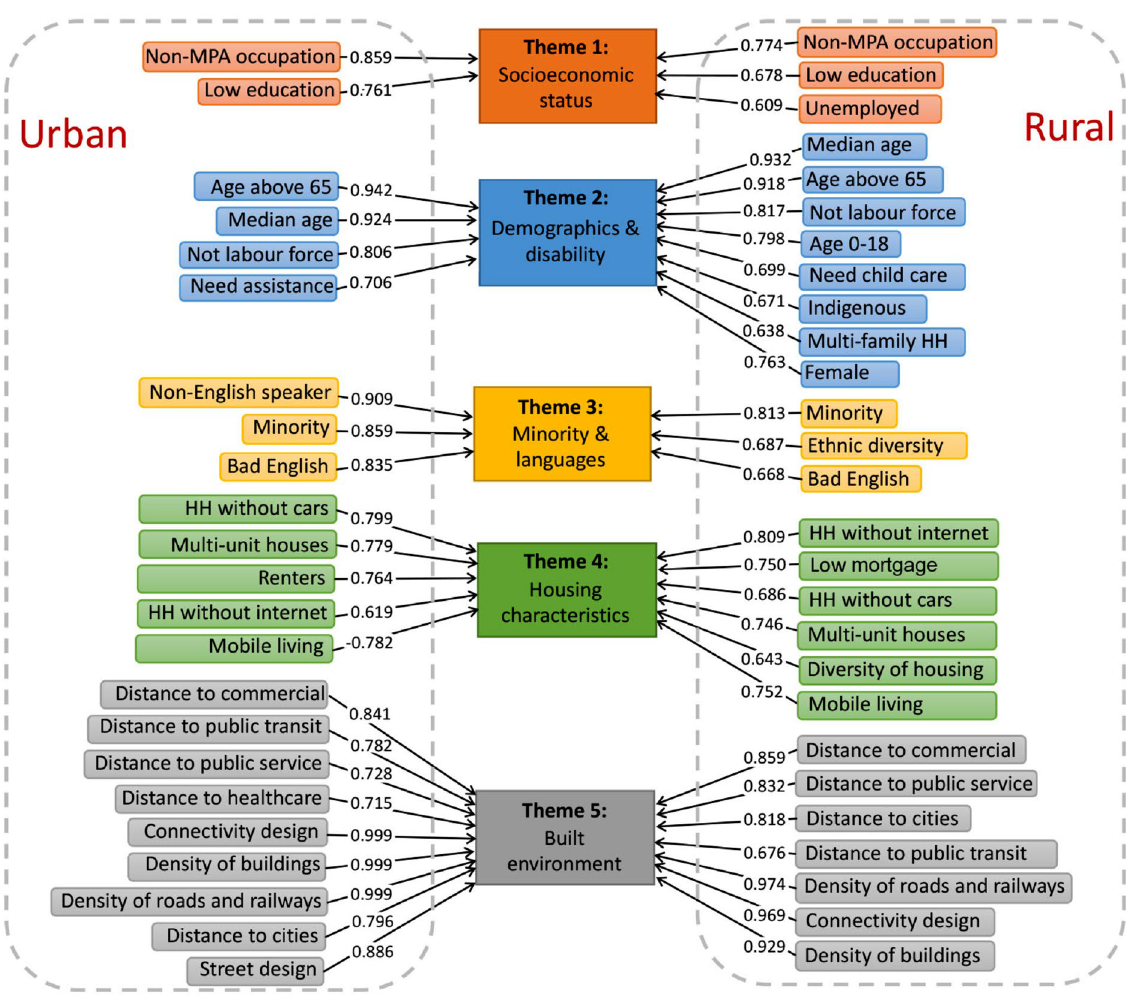
Figure 2. Reclassification of indicators in five themes for urban and rural space. MPA: managers, professionals, and administrators; HH: households; the numbers on the top of the arrows denote the loading factors of each indicator (Supplementary Tables S3 and S4), reflecting how much each indicator contributes to each principal component that is further classified to a particular theme. In urban areas, there are 10 principal components identified by the principal component analysis based on 23 indicators to measure the vulnerability index (Supplementary Table S5); they explain a total of 69.45% of data variance across SA1 areas. In rural areas, there are 11 principal components identified by the principal component analysis based on 27 indicators to measure the vulnerability index (Supplementary Table S6); they explain a total of 68.52% of data variance across SA1 areas. Principal components were further classified to five